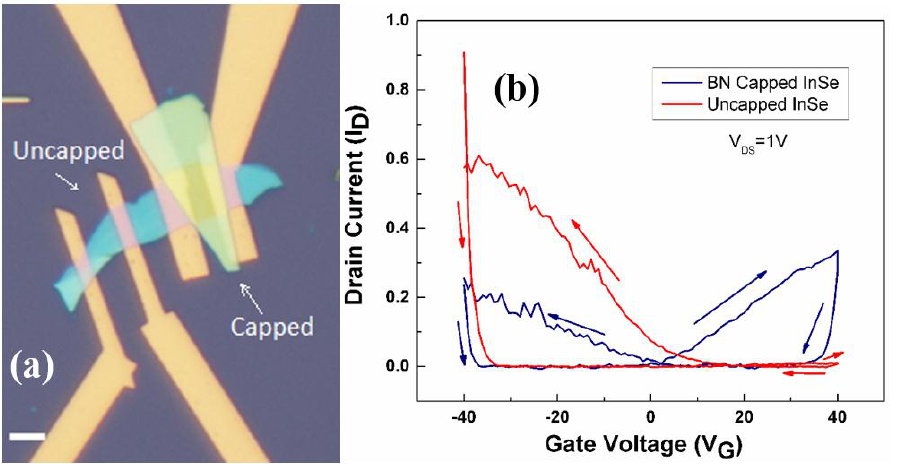
Figure 7. ( a ) Optical image of typical InSe back-gate transistor devices: in one device the channel is capped with a flake of hexagonal boron nitride (h-BN), whereas the other channel is exposed to atmosphere. ( b ) Behavior of the drain current as a function of the gate voltage for the cases of capped and uncapped InSe-based transistors. The uncapped device shows dominant p-type transport (even if with notable hysteresis), while the capped device noticeably displays ambipolar transport.